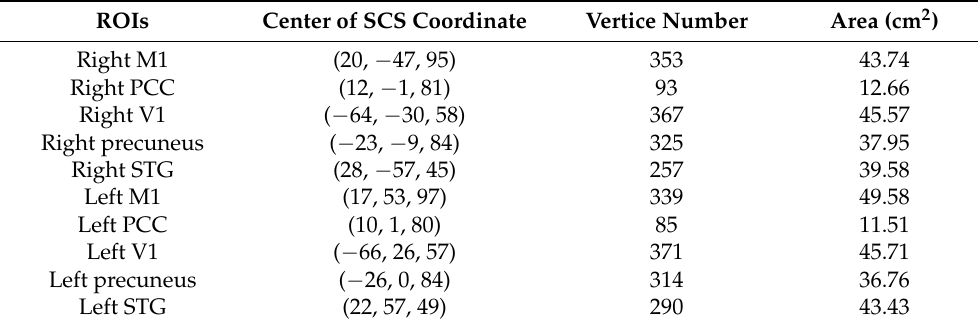
Table 2. The identified ROIs in the lesioned hemisphere on the Desikan-Killiany template. ROIs Center of SCS